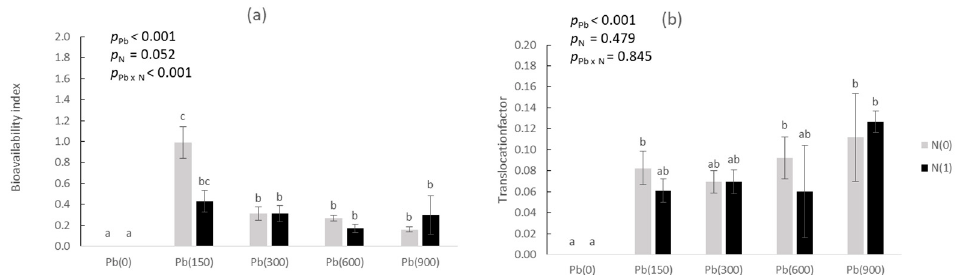
Figure 4. ( a ) Bioavailability index (BAI = Pb in DTPA extractions over Pb in aerial biomass) and, ( b ) translocation factor (TF = Pb in aerial biomass over Pb in roots) in purslane as affected by the addition of Pb (0, 150, 300, 600, and 900 mg kg − 1 soil) and with (N1) and without added nitrogen (N0). Different letters above each bar denote significantly different treatments at p < 0.05.